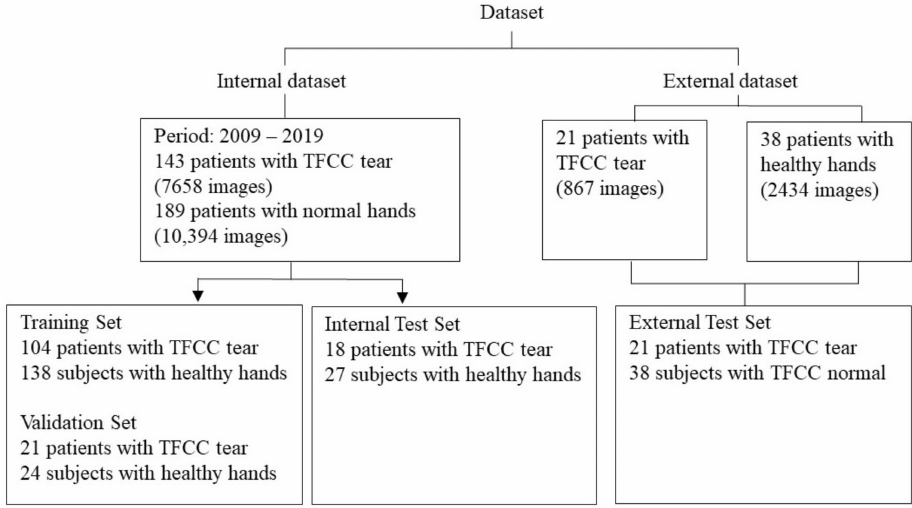
Figure 1. The local and external datasets for model training, validation, and